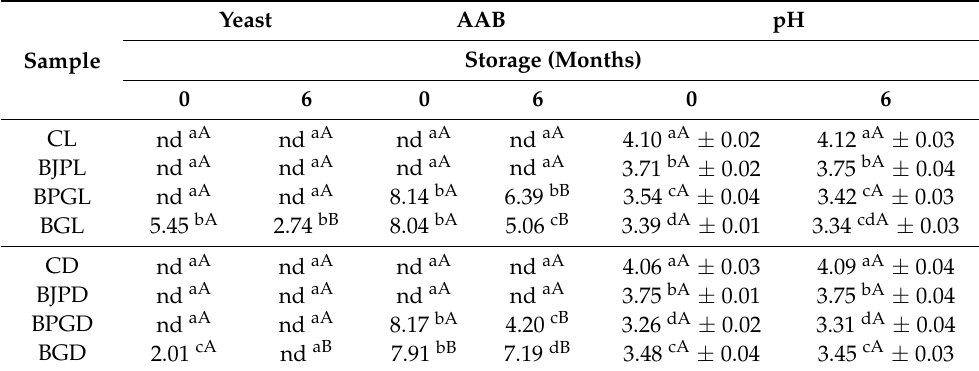
Table 2. Changes in the total count (log CFU mL − 1 ) of yeast, AAB, and pH values in study beer beverages after re-fermentation and after 6 months of storage